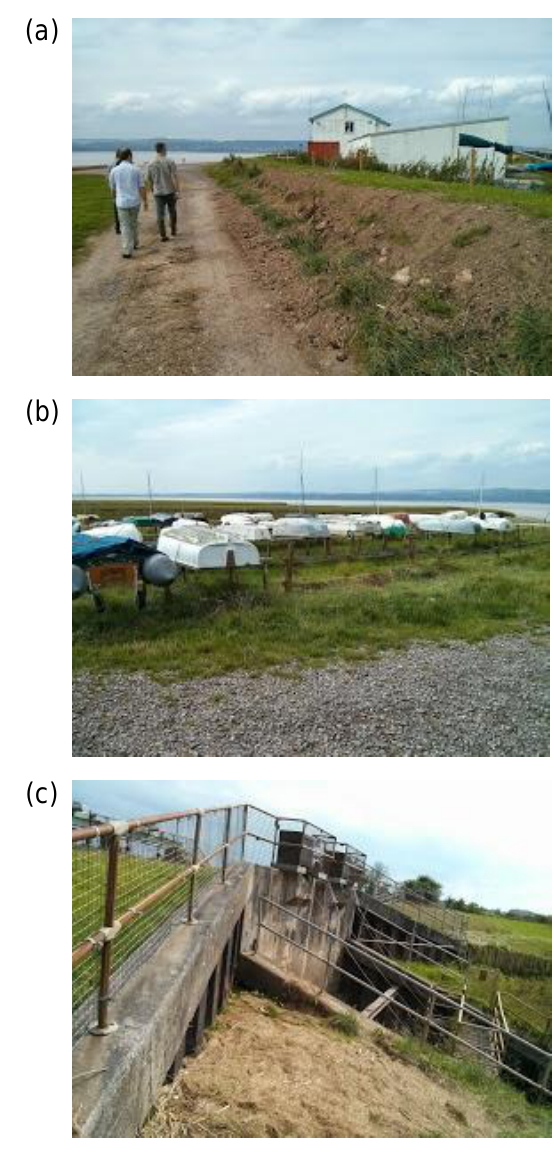
Figure 4. (a) Thornbury Sailing Club: localised club sea defences can be seen to the right of the track (Note: this area is situated between high-water and EA sea defences). (b) Thornbury Sailing Club: adaption to flooding events (boats stored on stilts) (Note: this area is situated between high-water and EA sea defences). (c) Old- bury Pill flood gate: one of the lower points indicated by LiDAR. Debris can be seen in the foreground, indicating the likely water level of the January 2014